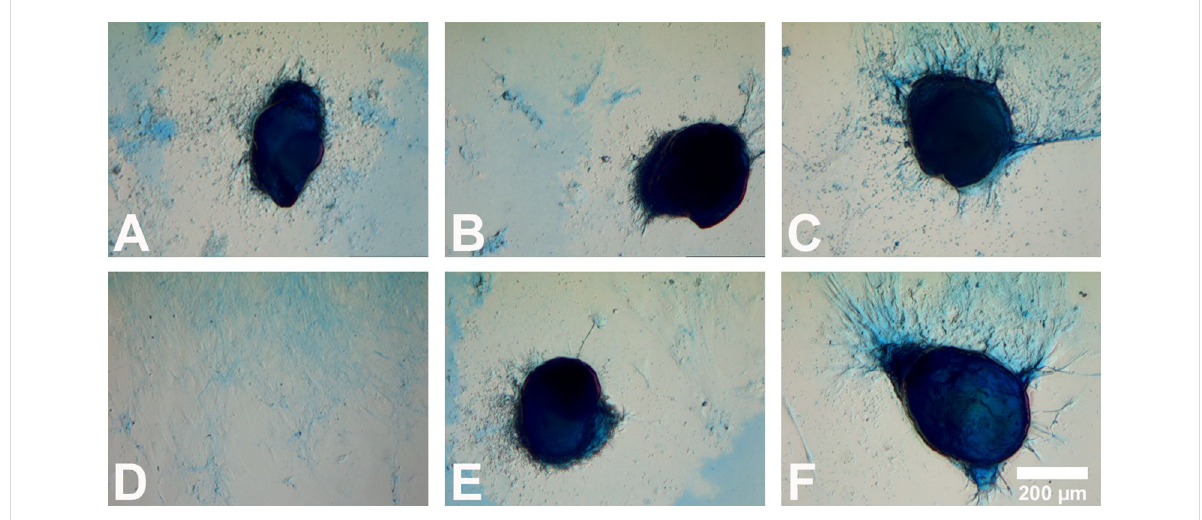
Figure 9: Influence of Ag-NP/Ag + ions on the chondrogenic differentiation of hMSCs. After 21 d of cell culture under chondrogenic conditions (bright- field images), alcian blue staining was used to visualize polyanionic glycosaminoglycan chains of proteoglycans in the cultured cells. hMSCs incu- bated in the presence of chondrogenic-differentiation media served as the positive control (A). hMSCs incubated in the presence of RPMI/FCS served as the negative control (D). Cells were incubated with 10 µg·mL − 1 (B) or with 5 µg·mL − 1 (C) Ag-NP in the presence of chondrogenic differentiation media. In addition, cells were incubated with 1.0 µg·mL − 1 (E) or 0.5 µg·mL − 1 (F) Ag + ions in the presence of chondrogenic differentiation media.